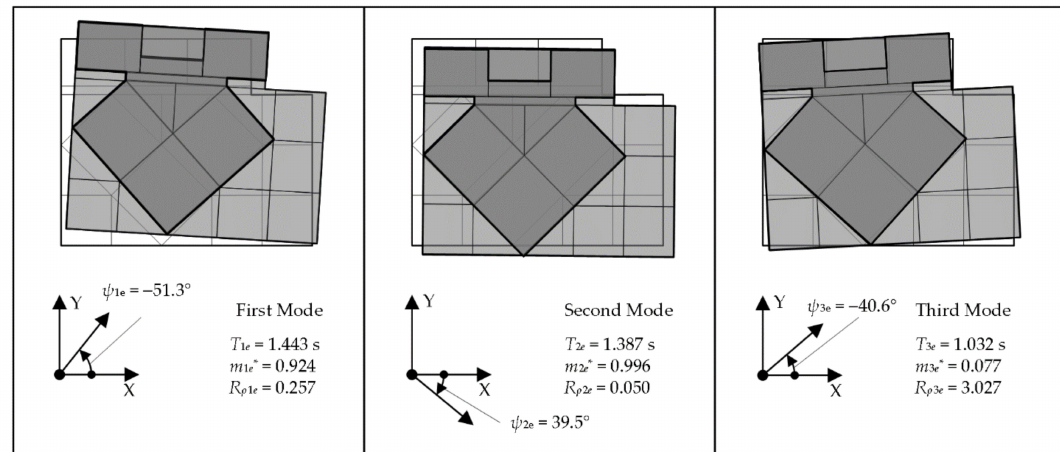
Figure 12. Shape of the first three natural modes of Model-Tf44 in the elastic